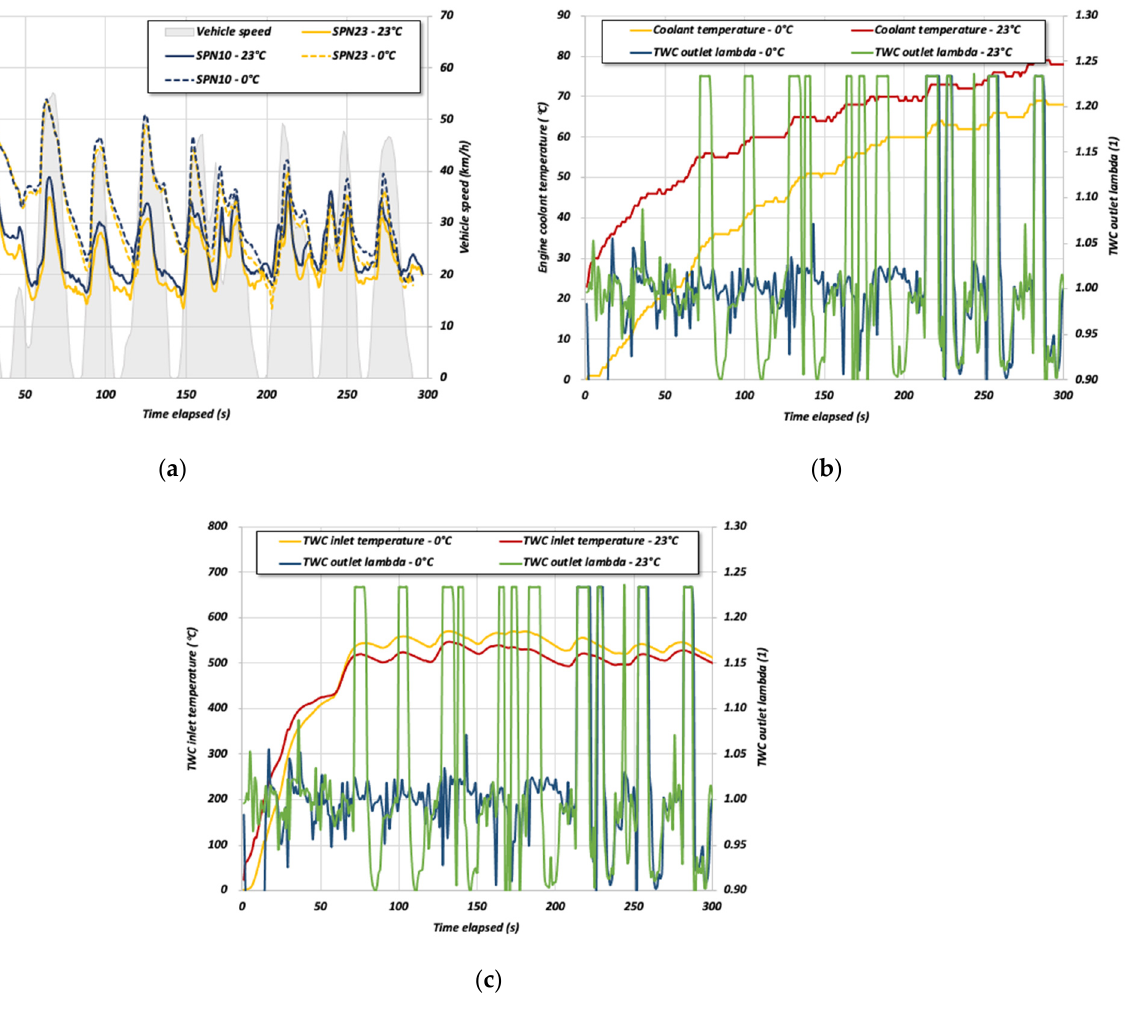
Figure 5. SPN23 and SPN10 comparison performed at 0 and 23 °C over the initial 300 s of RTS95. ( a ) Modal data of SPN23 and SPN10; ( b ) Coolant temperature and lambda for 0 and 23 °C; ( c ) TWC inlet temperature and lambda for 0 and 23 °C.